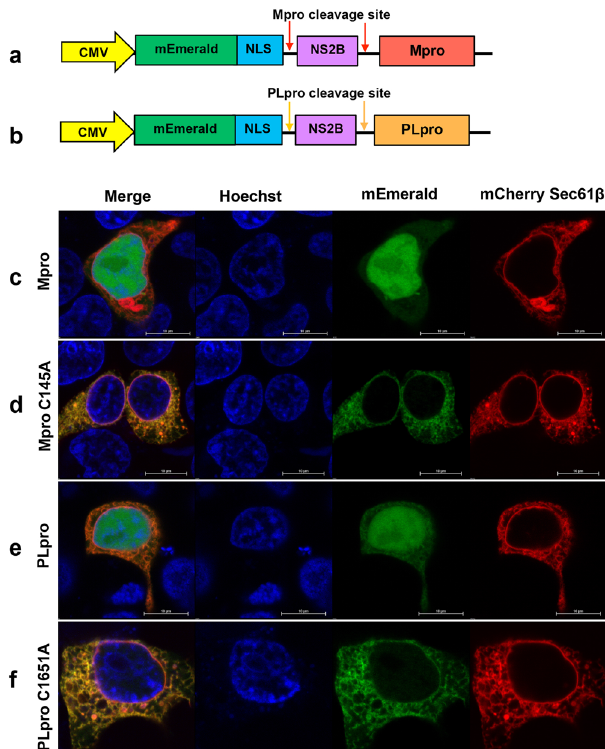
Fig. 1 In-cell protease (ICP) assay for screening inhibitors of SARS-CoV-2 proteases. a , b Constructs designed for the ICP assay containing mEmerald with nuclear localization signal (NLS), cleavage site for Mpro or PLpro, Zika virus NS2B followed by Mpro ( a ) or PLpro (amino acids 1541 – 1855 of nsp3) ( b ). c – f Localization of mEmerald-NLS (green) and ER marker mCherry- Sec61 β (red) at 6 h post-transfection and stained with nuclear stain Hoechst 33342 dye (blue), in ICP assay. c Cells transfected with ICP construct A, d cells transfected with ICP construct A with inactive Mpro mutant (C145A). e Cells transfected with ICP construct B, f cells transfected with ICP construct B with inactive PLpro mutant (amino acids 1561 – 1878 of SARS-CoV-2 pp11a). The ZIKV NS2B protein is a membrane protein that anchors the protease constructs to the ER membrane. HEK293T cells at 50% con- fl uency were co-transfected with ICP construct (Fig. 1a, b) and